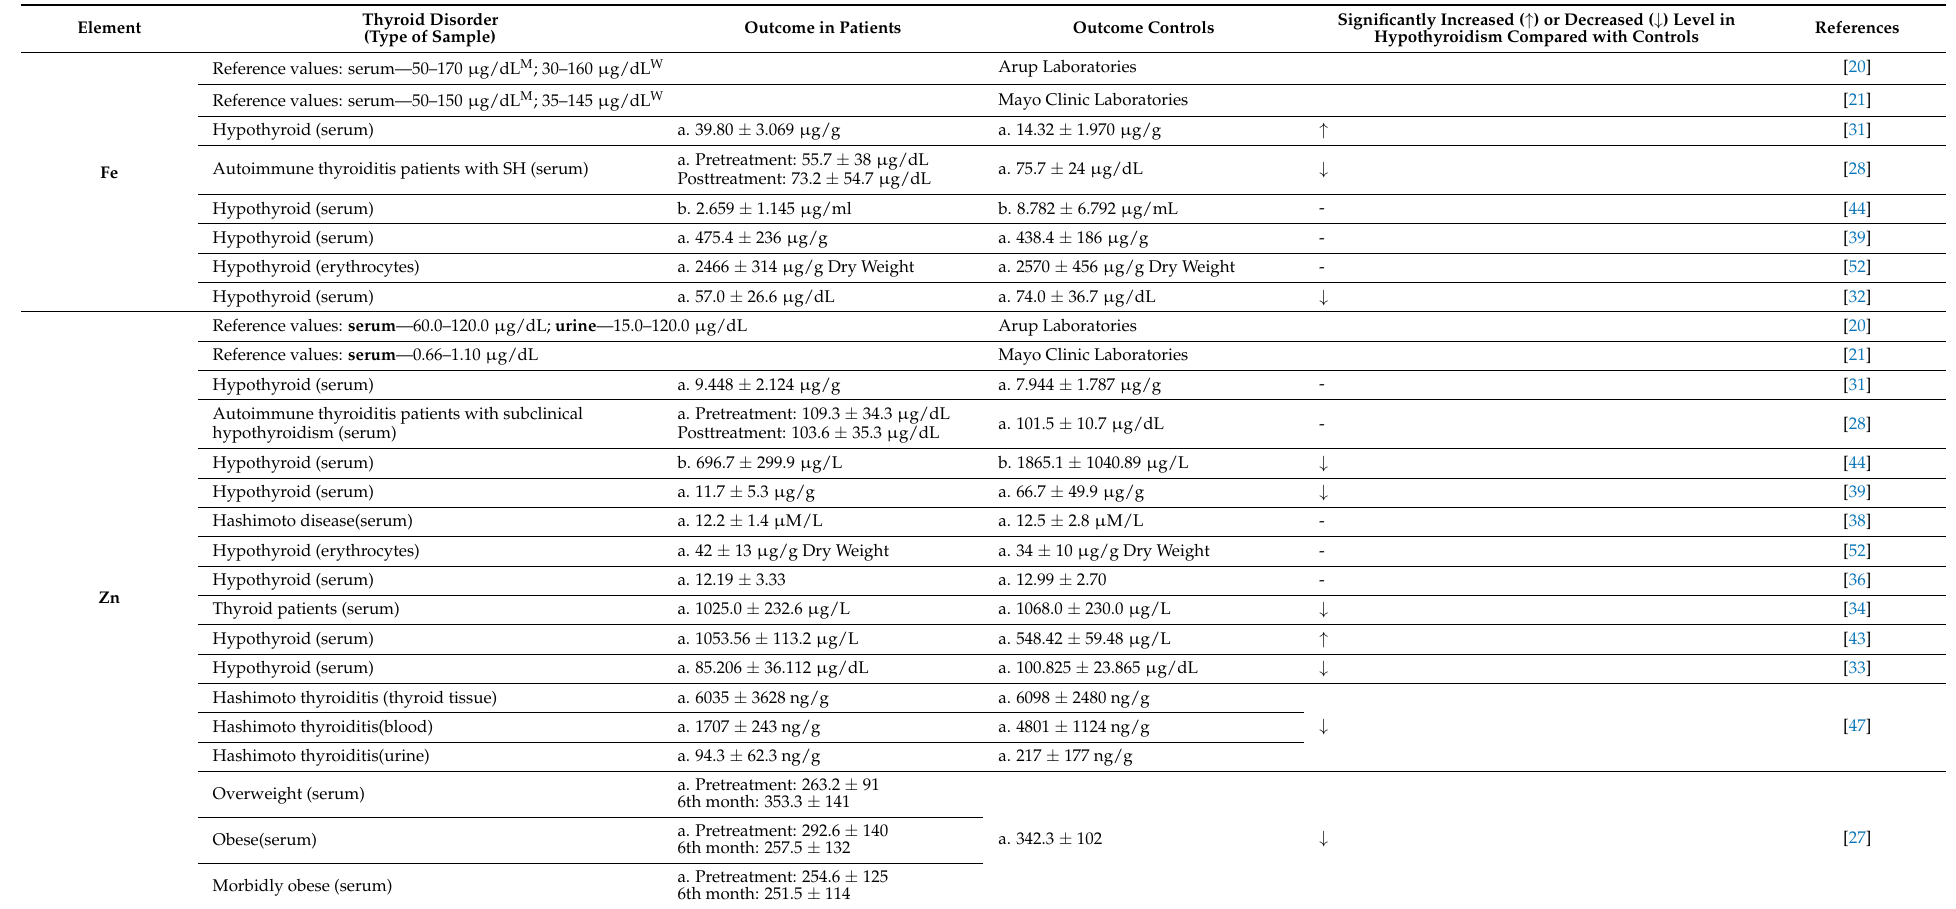
Table 2. Examples of determinations of selected elements in the research cited above. Data are presented as: a. mean ( ± SD), b. median ( ± SD).